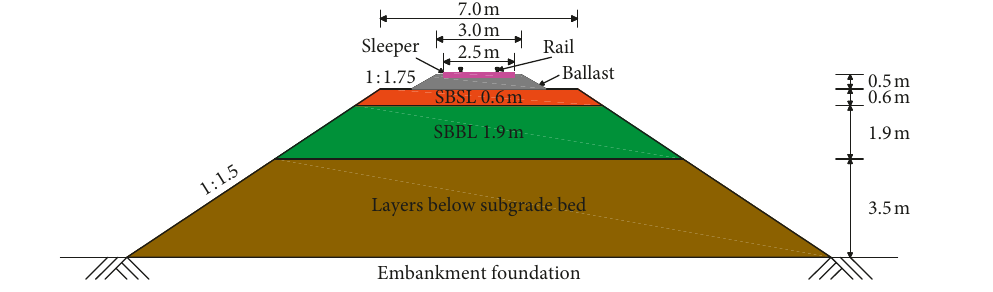
Figure 1: Embankment cross section.